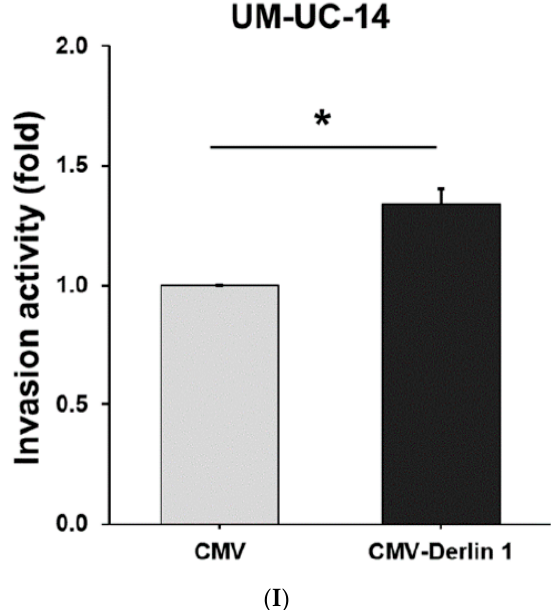
Figure 2. Derlin-1 is overexpressed in UTUC cell lines and enhances migration and invasion. ( A ) The Derlin-1 protein levels in cell by Western blot analysis with α -tubulin as a reference. Derlin-1 was highly expressed in BFTC909 and UM-UC-14 cells compared with SV-HUC-1 cells. ( B ) The Derlin-1 protein levels in BFTC909 cell lines by Western blot analysis after transfection with control siRNA (si-CT) or Derlin-1 siRNA (si-Derlin-1) as indicated (N = 3). ( C ) Knockdown Derlin-1 did not affect proliferation of BFTC909 cells (N = 3). ( D ) Knockdown Derlin-1 represses migration of BFTC909 cells (N = 3). ( E ) Knockdown Derlin-1 represses invasion of BFTC909 cells (N = 3). ( F ) The protein levels of well-known EMT markers were examined after knockdown of Derlin-1 in BFTC909 cells (N = 3). Knockdown Derlin-1 reduces the expression level of Snail and MMP2 in BFTC909 cells. The E-cadherin, N-cadherin, vimentin and occludin protein expression levels were not changed significantly. ( G ) Overexpression of Derlin-1 reduces the protein level of occludin and induces MMP2 and Snail in UM-UC-14 cells. The expression level of E-cadherin, N-cadherin was not changed significantly. ( H ) Overexpression of Derlin-1 enhances migration of UM-UC-14 cells. ( I ) Overexpression of Derlin-1 enhances invasion of UM-UC-14 cells. Data were represented as mean ± SD; * p < 0.05, ** p < 0.01. N.S: not significant. Full Western blot images can be found at File S1.